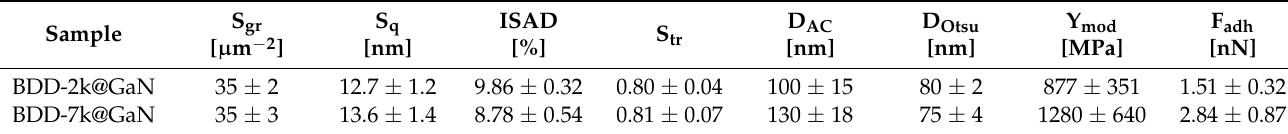
Table 1. Surface texture and mechanical characteristics derived from AFM images: S gr —planar grain concentration, S q — surface roughness (RMS), ISAD—image surface area difference, S tr —texture anisotropy ratio, D AC —mean grain size from the autocorrelation function, D Otsu —grain size estimated using Otsu’s method, Y mod —mean Young’s pseudo-modulus, F adh —mean adhesion